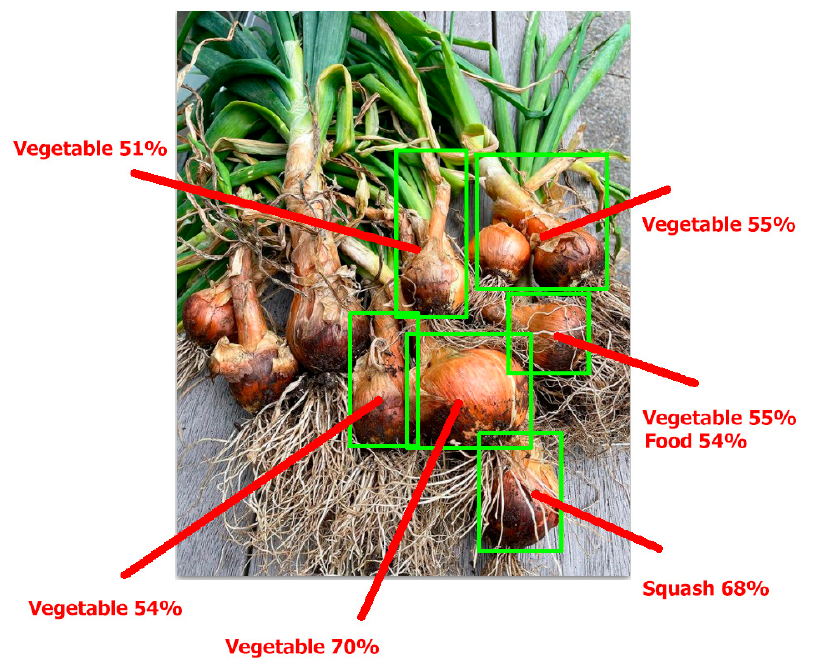
Figure 9. Output from Google Vision—Object identification. Table 2. Labels based on Google Vision (example for an image of an